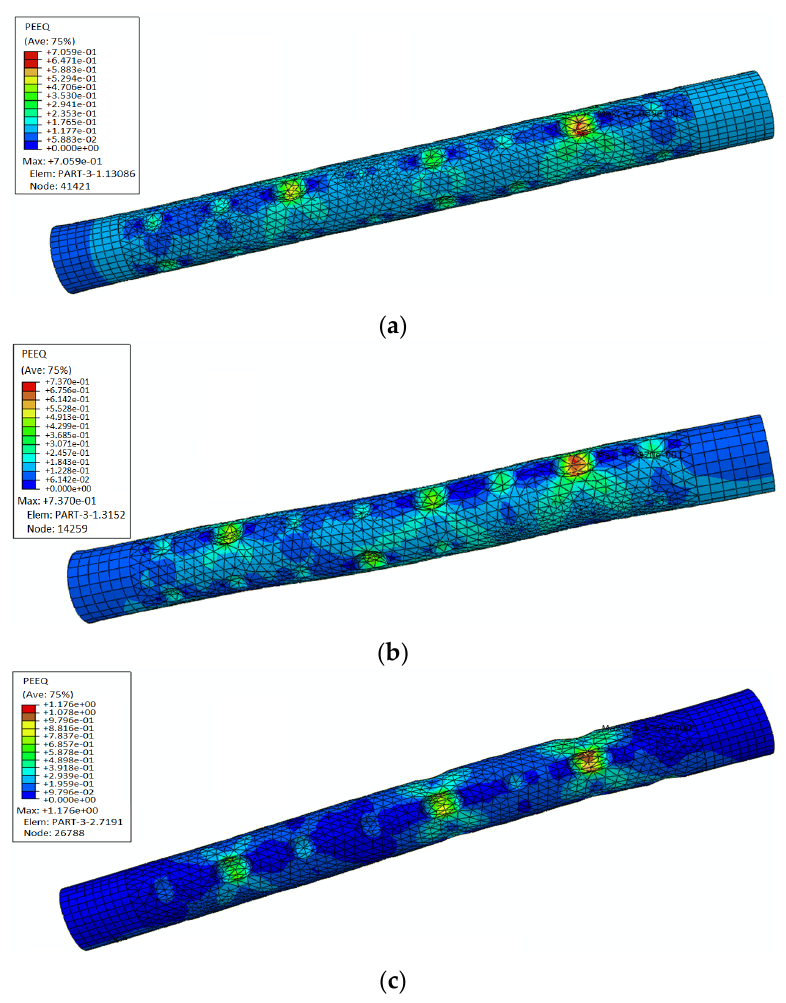
Figure 14. Results of finite element analysis based on Table 8: ( a ) R a ‐ 1; ( b ) R a ‐ 2; ( c ) R a ‐ 3.